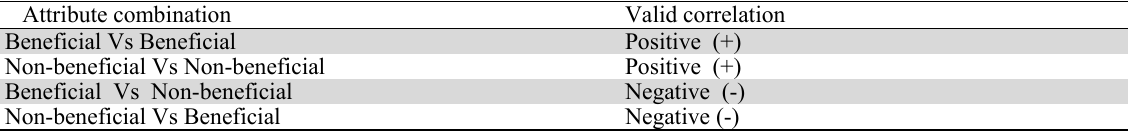
Valid correlations between different combinations of attributes Attribute combination Valid correlation Beneficial Vs Beneficial Positive (+) Non-beneficial Vs Non-beneficial Positive (+) Beneficial Vs Non-beneficial Negative (-) Non-beneficial Vs Beneficial Negative